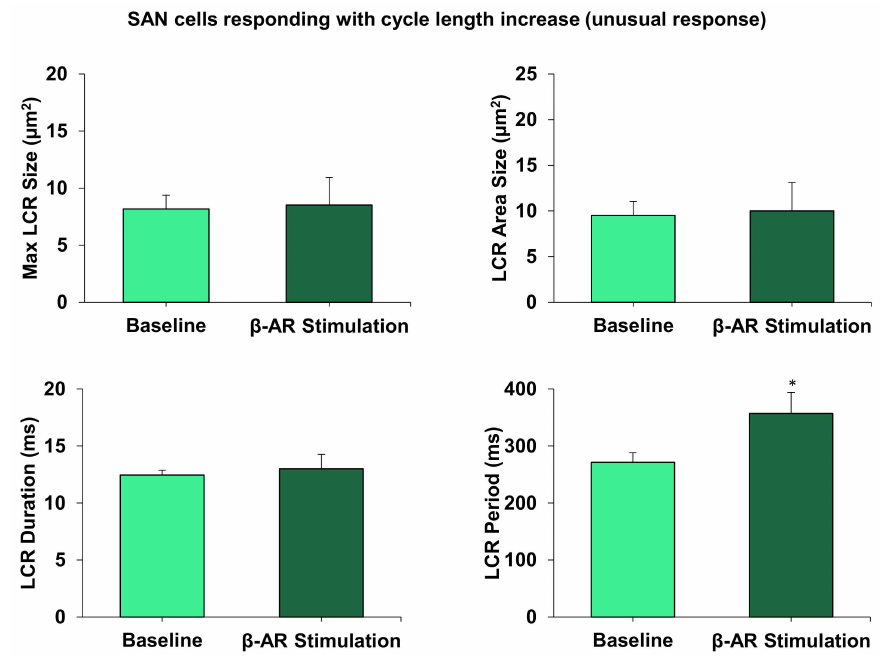
Figure 6. LCR characteristics did not change, except for in the LCR period, in cells responding with the cycle length increase (rate decrease, i.e., a new response type). * p < 0.05, n = 5